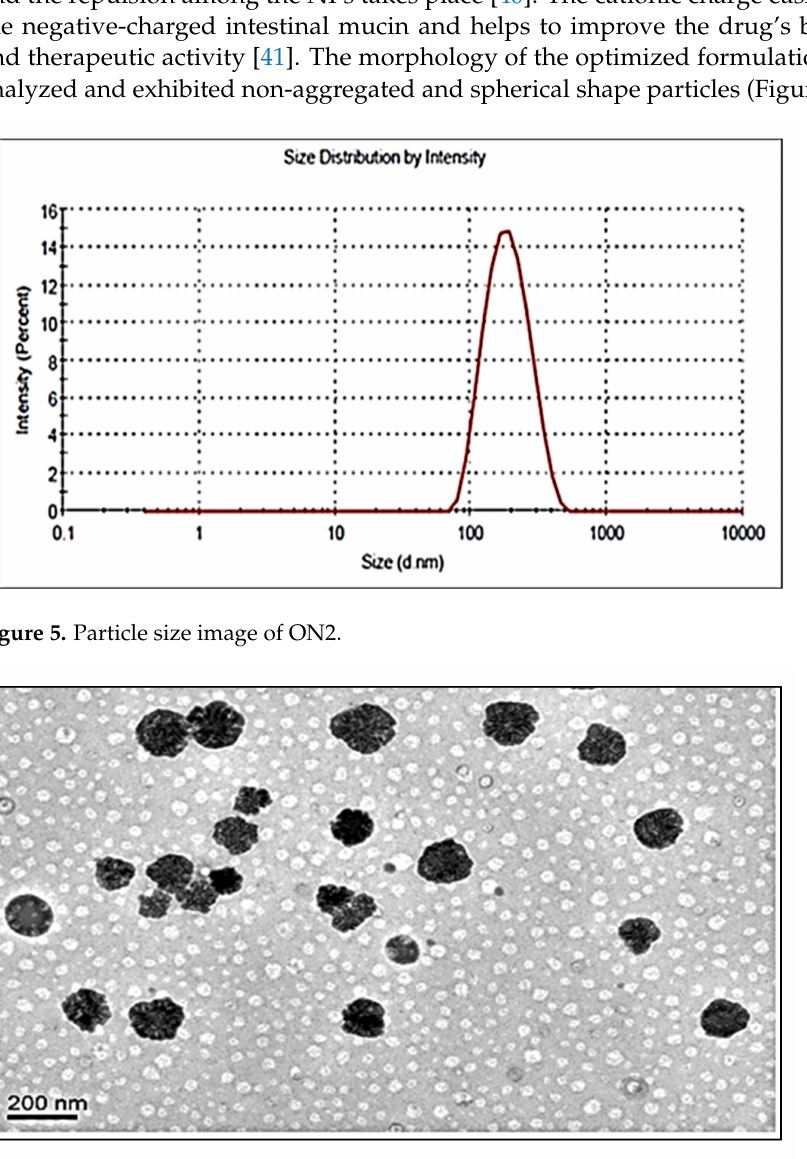
Figure 6. Surface morphology image of